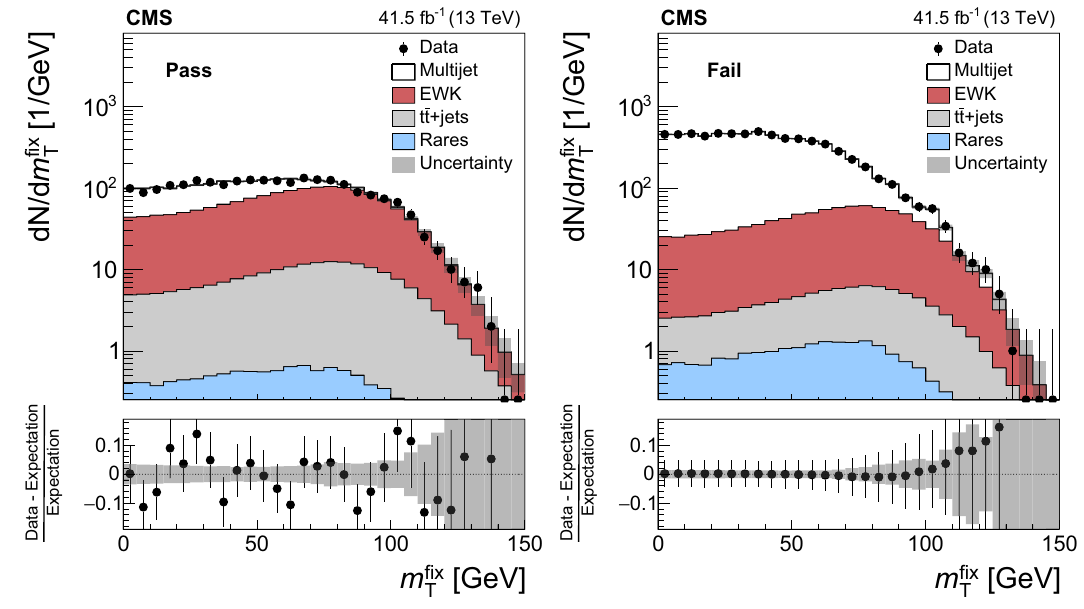
Fig. 5 Distributions of m fix for events containing an electron candi- number of multijet events in the fail sample is computed by subtracting T date of 25 < p T < 35GeV in the ECAL barrel, which (left) passes the sum of EWK, tt+jets, and rare background contributions from the the nominal selection and (right) passes the relaxed, but fails the nomi- data. The misidentification probabilities are derived separately for each nal selection. The “electroweak” (EWK) background refers to the sum era: this figure shows, as an example, the results obtained with the 2017 of W+jets, DY, and diboson production. The “rare” backgrounds are data set. The uncertainty band represents the total uncertainty after the defined in the text. The data in the fail sample agrees with the sum of fit has been performed multijet, EWK, tt+jets, and rare backgrounds by construction, as the